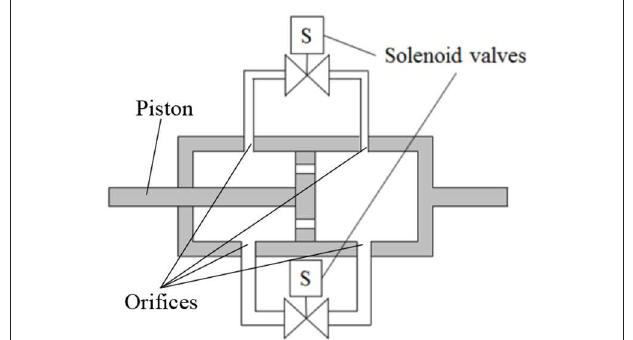
FIGURE 2 | Schematic illustration of a semi-active isolator.